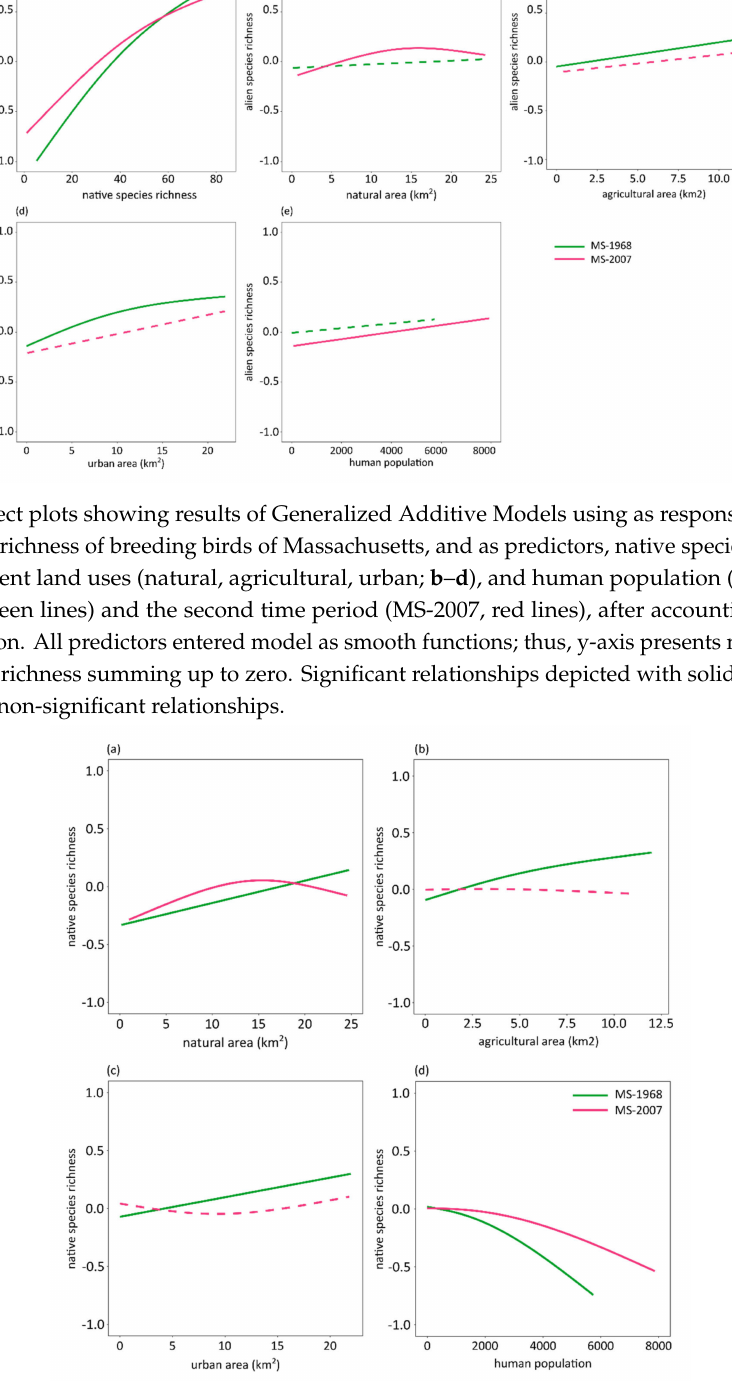
Figure 4. E ff ect plots showing results of Generalized Additive Models using as response variable the native species richness of breeding birds of Massachusetts, and as predictors area of di ff erent land uses (natural, agricultural, urban; a – c ) and human population ( d ) for the first (MS-1968, green lines) and the second time period (MS-2007, red lines) after accounting for spatial autocorrelation. All predictors entered model as smooth functions; thus, y-axis presents mean-centered native species richness summing up to zero. Significant relationships depicted with solid lines; dashed lines denote non-significant